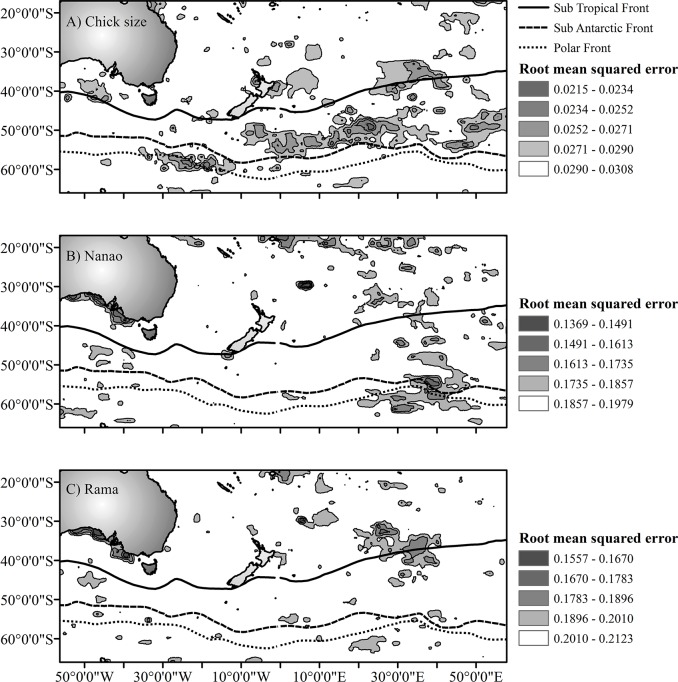
Mapped root mean squared error for generalized boosted regression models in the study area.Areas with the lowest root mean squared error represent regions where oceanographic factors for the month of March from 1979–2010 best capture the variability in the chicksize (a), nanao (b), and rama (c) indices from Humphries [25]. Frontal regions are depicted to demonstrate the boundaries of Southern Ocean zones.